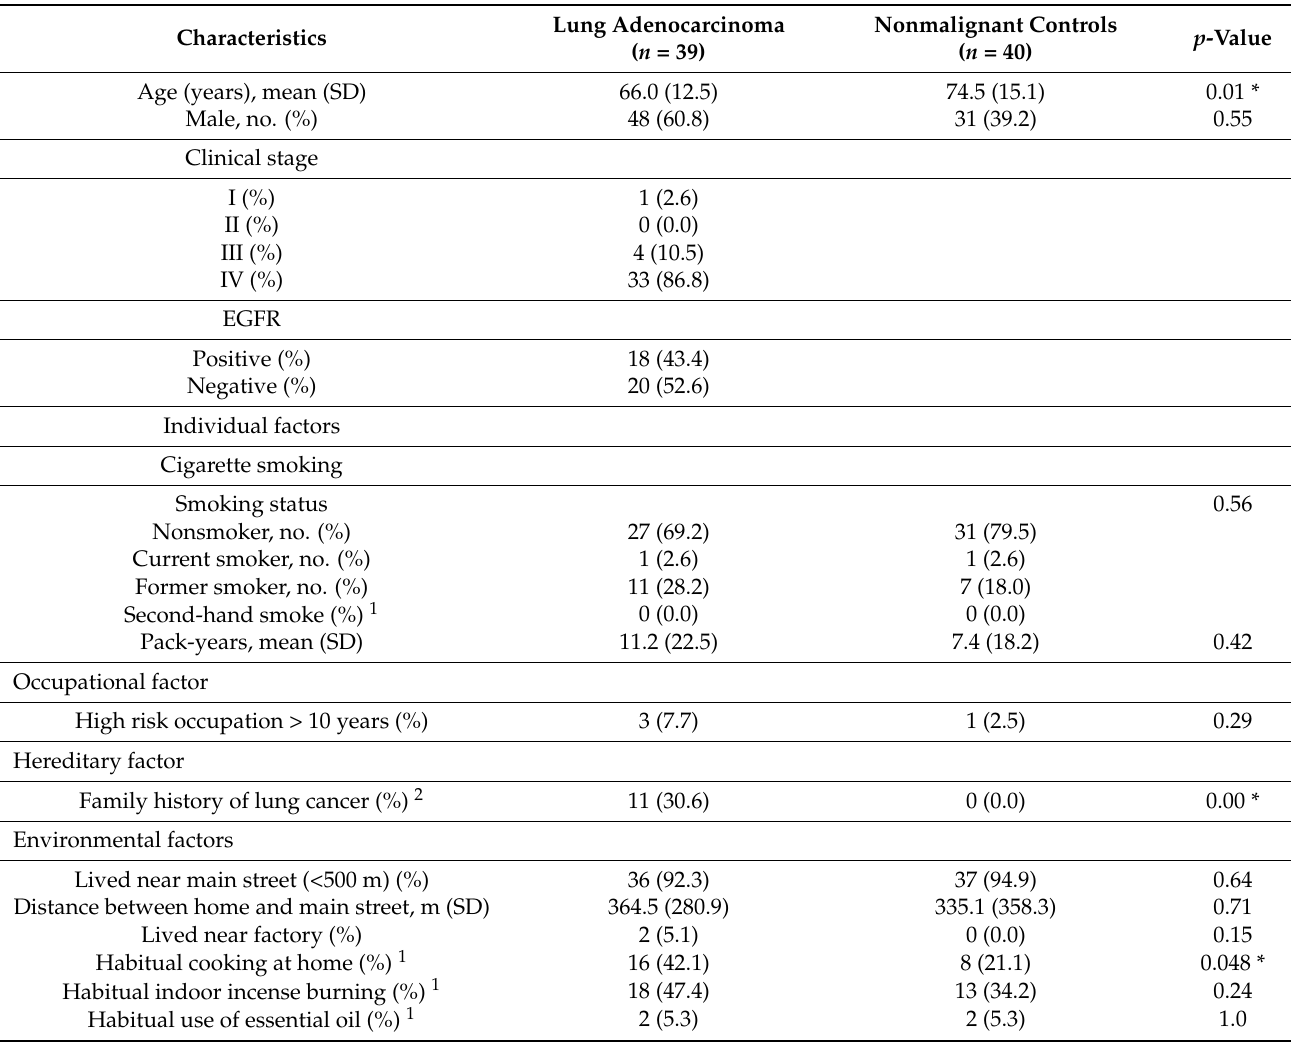
Table 1. Demographic characteristics of the study subjects.